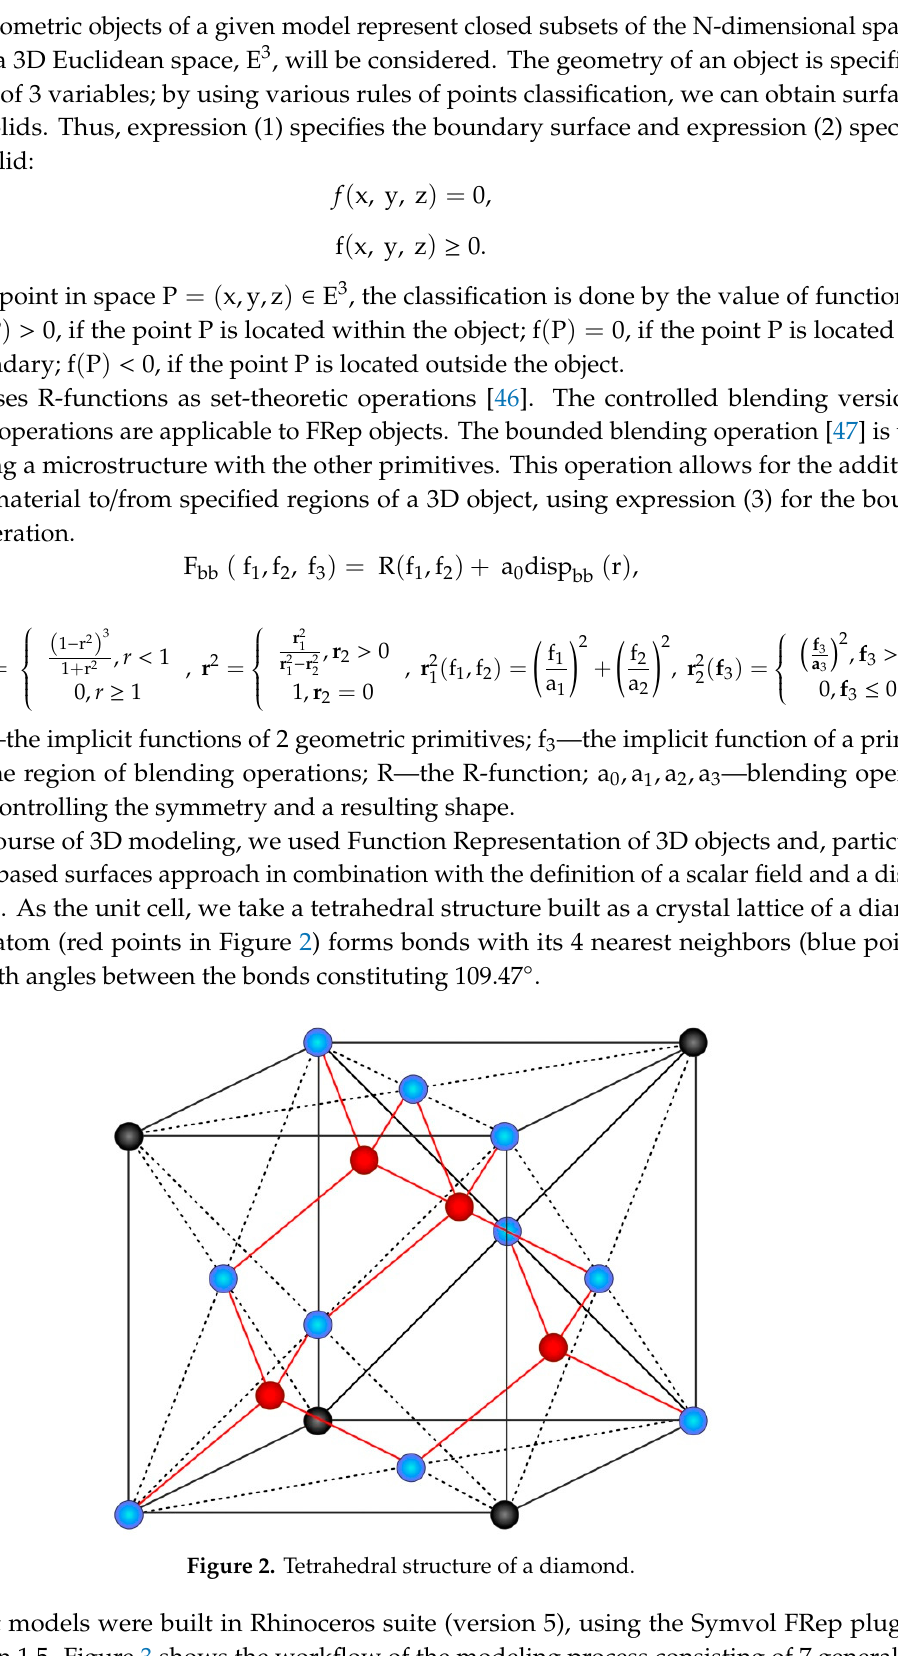
Figure 3. Workflow of the modeling process with Symvol FRep plugin for Rhino version 1.5. 2.2. Fabrication To analyze the possibility of fabricating Al 2 O 3 ceramic implants by 3D printing, we conducted several experiments to fabricate cylindrical specimens. As a ceramic feedstock, we used 3DMix alumina paste produced by 3DCeram (Limoges, France). The weight fraction of the alumina powder in the paste constitutes 84%. We used a Ceramaker 900 (3DCeram, Limoges, France)